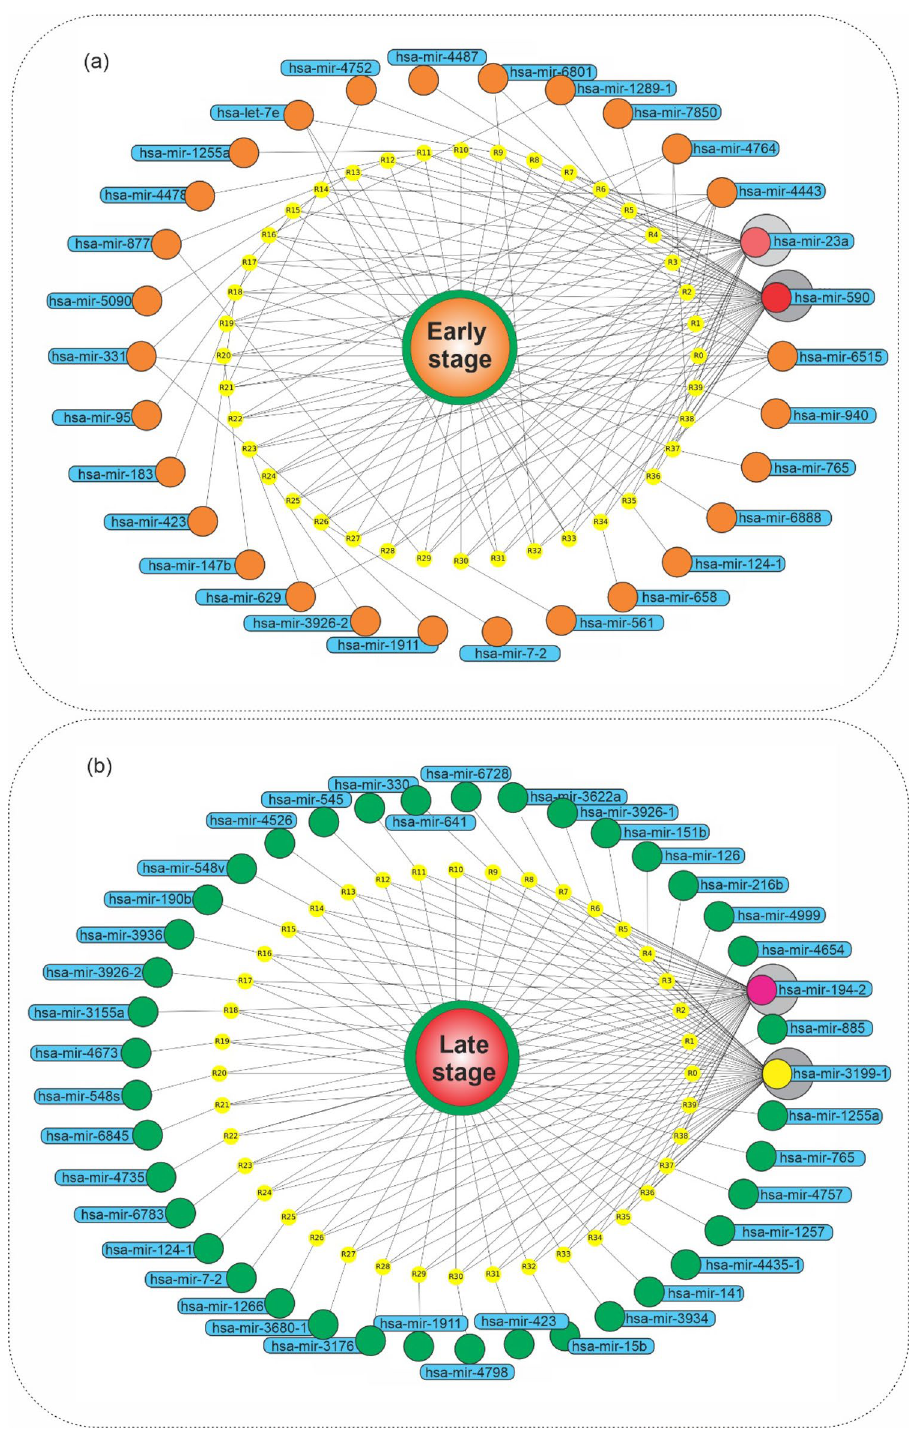
Figure 2. Graph network of miRNAs at early- and late-stage of HCC. Graph network of ( a ) early-stage related association rules (with lift > 1.16) and ( b ) late-stage related association rules (with lift > 1.2), in which the early- stage phenotype, its rules, and related miRNAs were presented, by orange, yellow, and blue colors, respectively. Python programming language (version 3.9) and Matplotlib library (version 3.6.0) were used to draw the plots, all of them are open